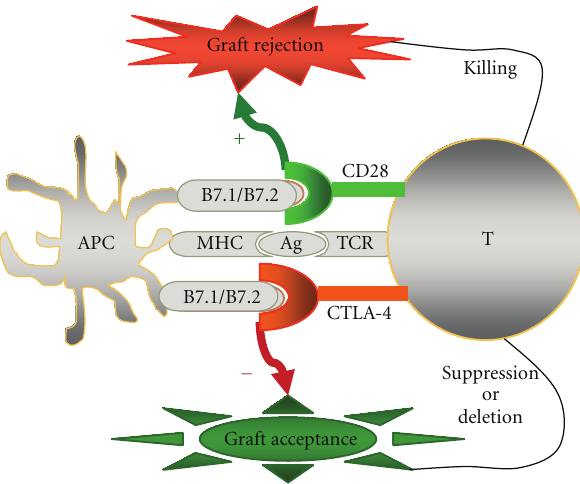
Figure 2: The outcome of transplantation is determined by cosignalling. Full T-cell activation requires two signals. The first is antigen-specific recognition of TCR and alloantigen presented on MHC. The second is costimulation which can be positive or negative. In the presence of positive cosignalling (such as with CD28), T-cell proliferation occurs. These activated T cells attack the donor graft and results in graft rejection. One the other hand, the activated T-cell response is terminated in the presence of negative co-signalling (such as with CTLA-4) which protects the graft from